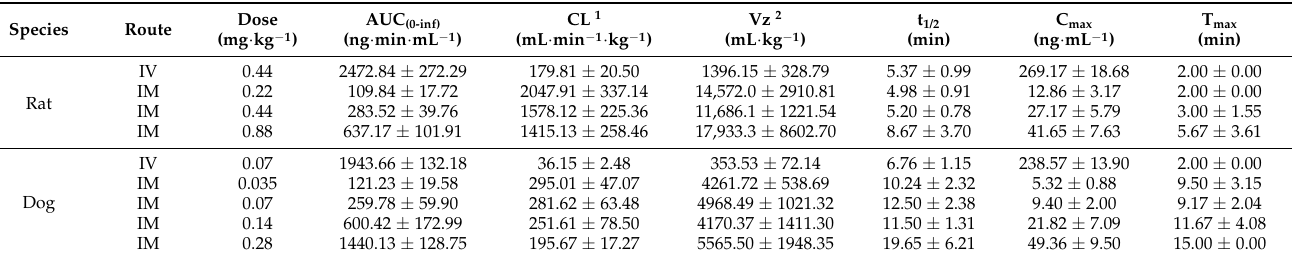
Figure 2. Mean plasma concentrations of GeXIVA[1,2] over time in rats (A) and dogs (B) after intramuscular (IM) or intravenous (IV) administration of GeXIVA[1,2] ( n = 6). Table 2. Pharmacokinetic parameters of GeXIVA[1,2] in rats and dogs after a single dose of GeX- IVA[1,2] ( n =